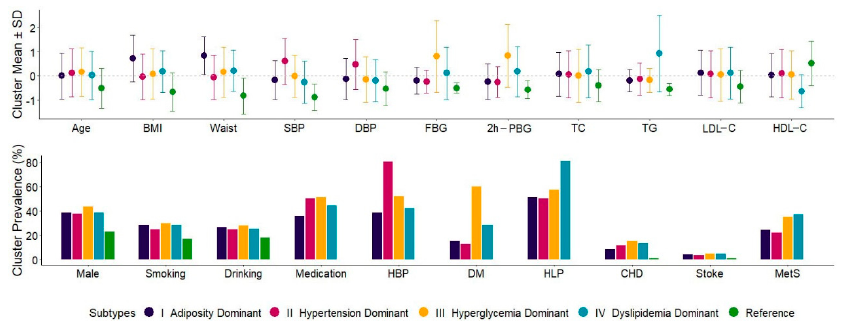
Figure 2. Quantitative and binary distributions for characteristics of different subtypes *. * Continu- ous variables are shown as means and standard deviations after being standardized to a unified scale. BMI, body mass index; Waist, waist circumference; SBP, systolic blood pressure; DBP, diastolic blood pressure; FBG, fasting blood glucose; 2h-PBG, 2 h postprandial blood glucose; TC, total cholesterol; TG, triglyceride; LDL-C, low-density lipoprotein cholesterol; HDL-C, high-density lipoprotein choles- terol; HBP, hypertension; DM, type 2 diabetes; HLP, hyperlipidemia; CHD, coronary heart